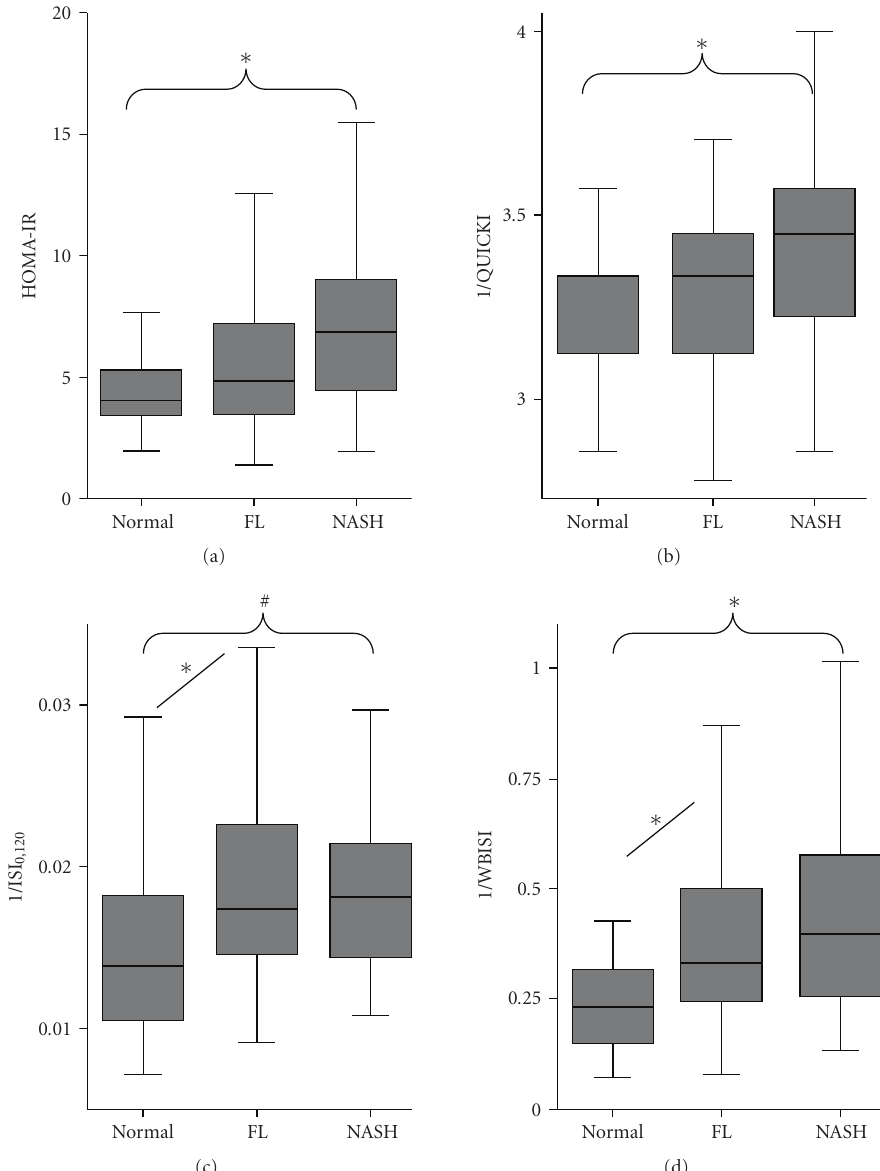
Figure 1: Box plot analysis of surrogate markers of hepatic and whole body insulin resistance along the spectrum of NAFLD. (a) HOMA- IR and (b) 1/QUICKI calculated from fasting insulin and glucose levels represent hepatic (central) insulin resistance. (c) 1/ISI 0,120 and (d) 1/WBISI calculated from both fasting and 2 hours postglucose challenge insulin and glucose levels represent whole body insulin resistance, which is composite of hepatic and peripheral insulin resistance. Groups were compared by nonparametric test (Kruskal-Wallis H test) and post hoc corrections. ∗ = P < . 01 and # = P < .